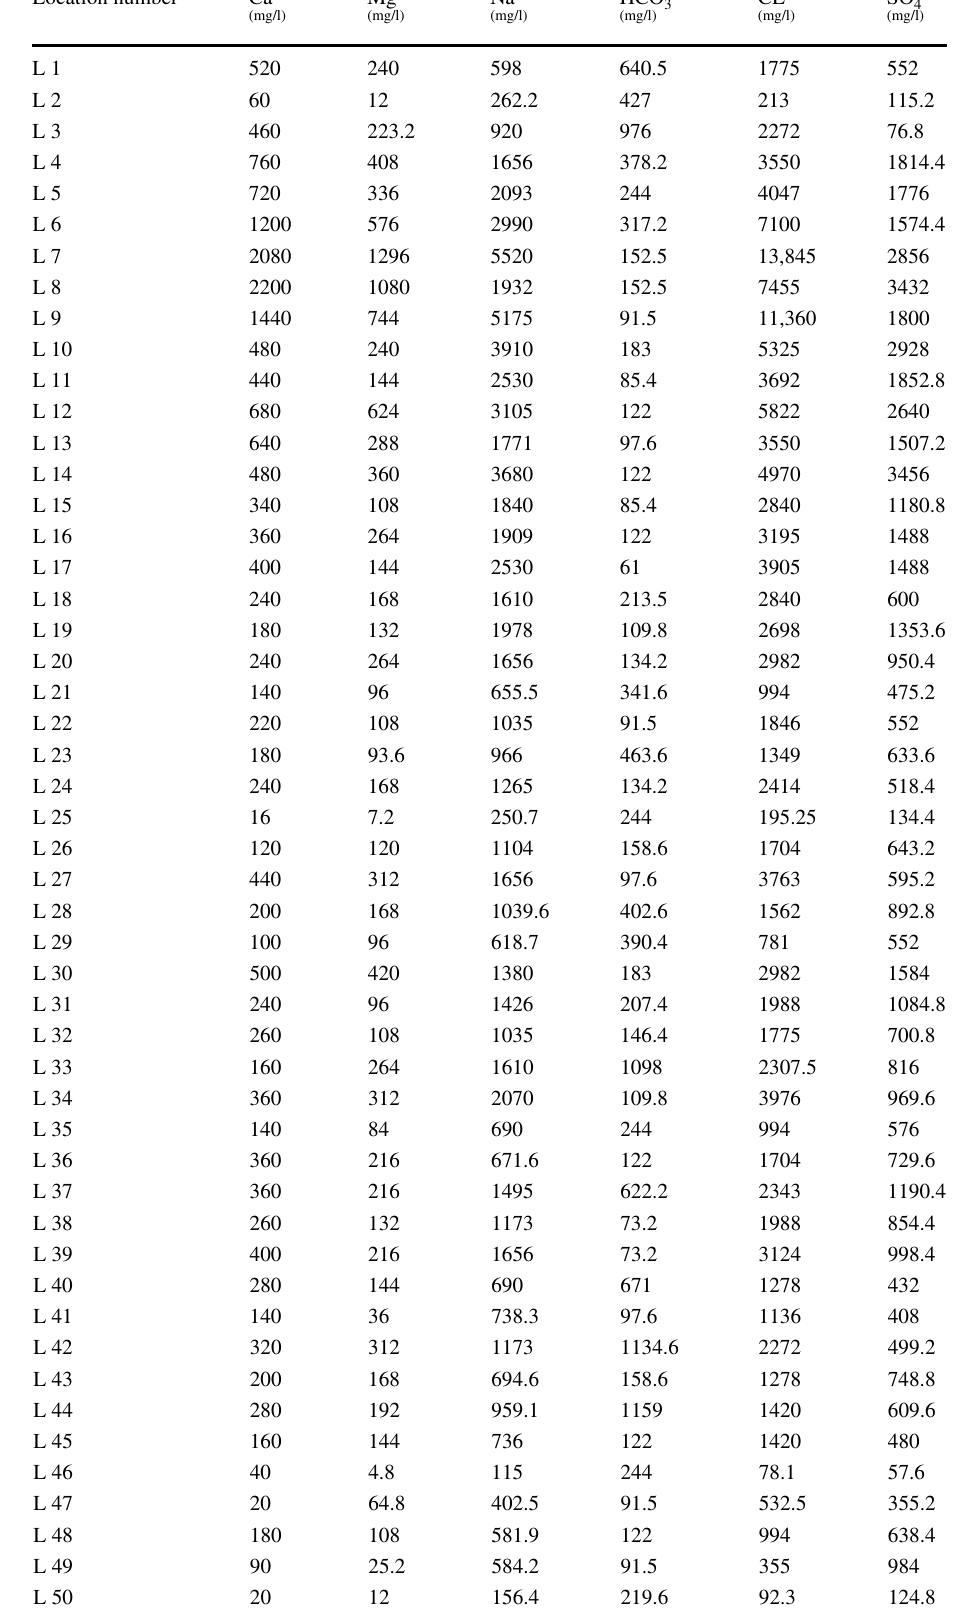
Table 4 Concentration of major cation and anions in groundwater